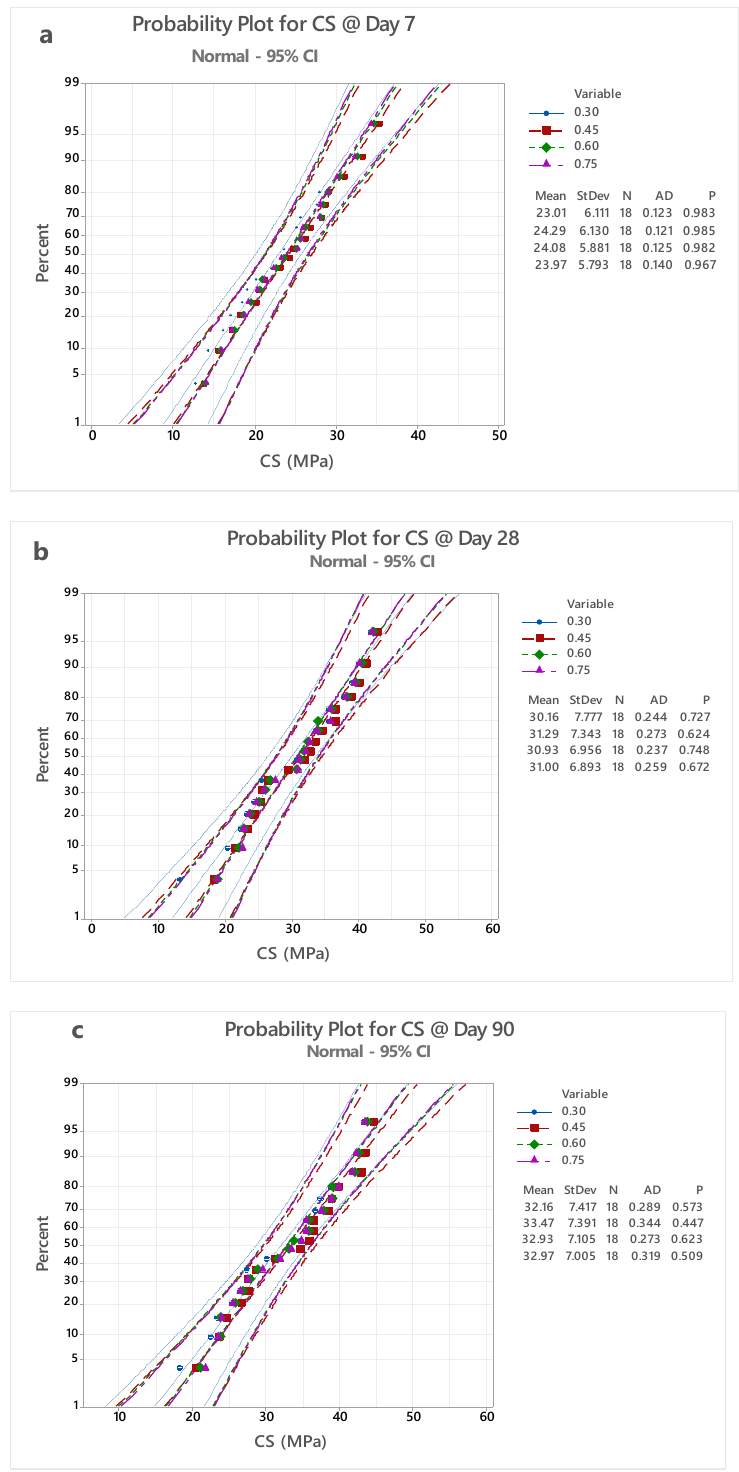
Figure 5. ( a ) Shows the PP curve for CS results at day 7; ( b ) shows the PP curve for CS results at day 28 and ( c ) shows the PP curve for CS results at day 90. Figure 5a–c shows the PP curve for CS results. PP curve was analyzed using mini tab software. GPC specimens with an A/B ratio of 0.30 testing after day 7 show a probability factor of 0.983, as seen in Figure 5a. It indicates 98.3% as the CS results line which varies linearly. Similarly, GPC specimens with an A/B ratio of 0.45, 0.60, and 0.75, tested